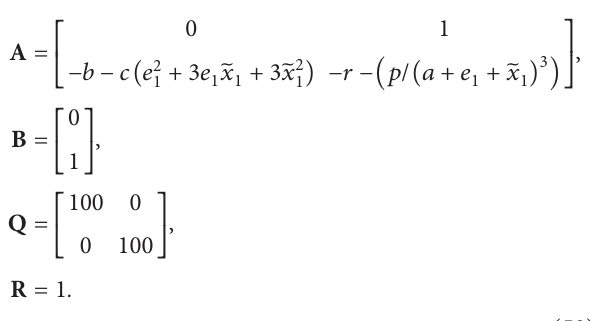
� x − 􏽥 x � x − 􏽥 x and e , by considering q 1 1 1 2 2 2